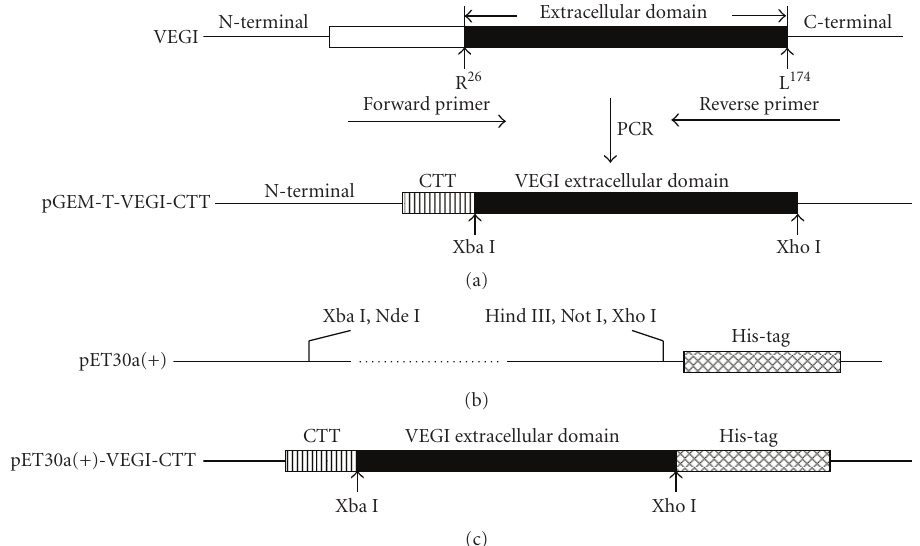
Figure 1: Schematic representation of the cloning steps of VEGI-CTT fragment into the expression vector pET30a(+). (a) The vector Psw200 containing full-length VEGI gene was used to amplify recombinant cDNA of human VEGI-CTT for 483bp by PCR. The recombinant cDNA of human VEGI-CTT was cloned into pGEM-T, and produced pGEM-T-VEGI-CTT. (b) pET30a(+) vector with His-tag upstream of the multiple cloning site that contains XbaI and XhoI. (c) pET30a(+) carrying XbaI-XhoI fragment of VEGI-CTT to produce pET30a(+)-VEGI- CTT. The resulting fusion gene contains internal His-tag and